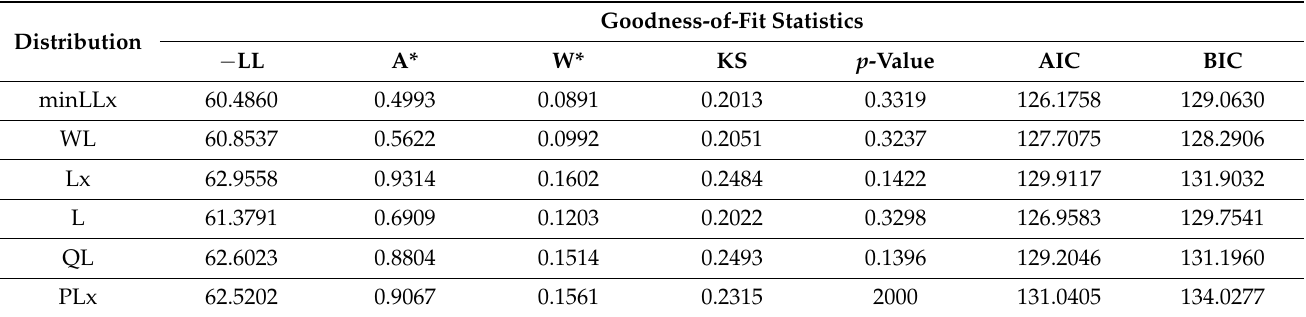
Table 9. Some goodness of fit statistics for the models fitted to the second data